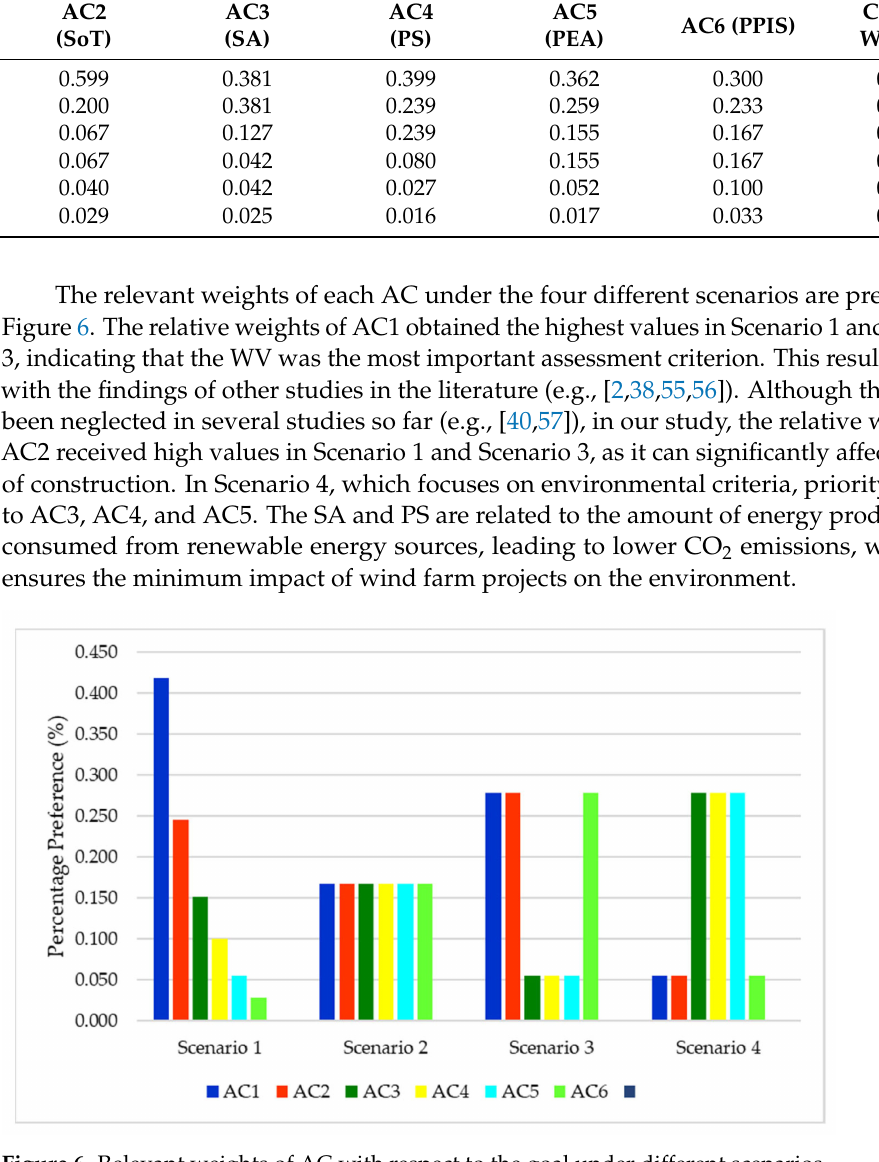
Figure 6. Relevant weights of AC with respect to the goal under different